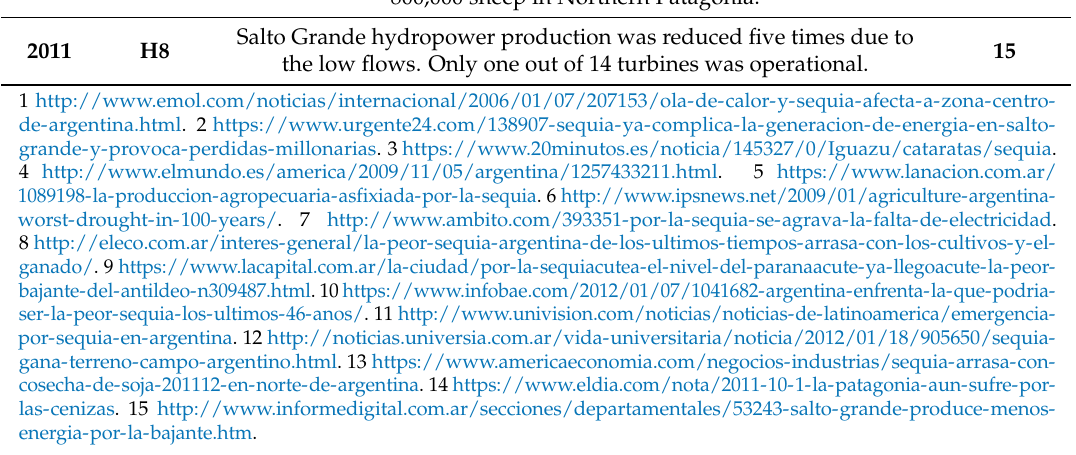
Table A2. Number of farming emergencies declared by provincial and national authorities due to drought events by province and year. Source “Bolet í n Oficial de la Rep ú blica Argentina” [39].